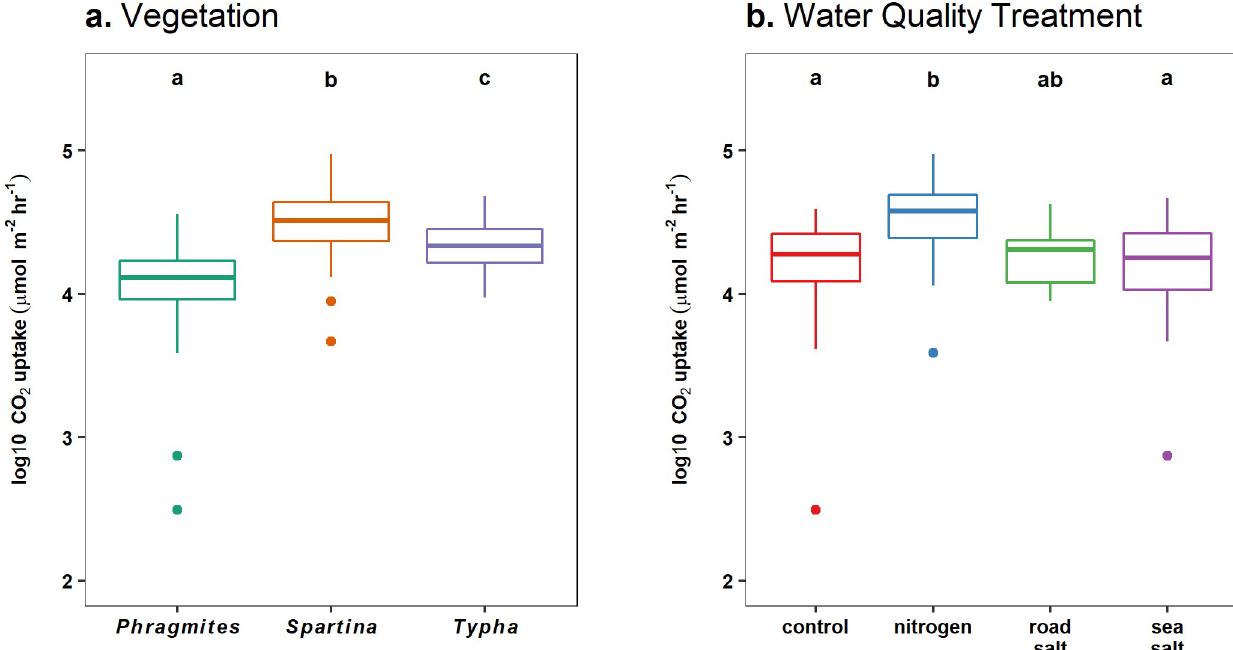
Fig 2. CO 2 uptake differed among vegetation and water quality treatments. Boxplots of 2017 log-transformed CO 2 uptake rates (samples pooled across July, August, September sampling campaigns) by (a) vegetation and (b) water quality treatments. Note that measurements were estimates of net ecosystem exchange, integrating photosynthetic uptake, auto and heterotrophic respiration from transparent chambers. Differences between groups are indicated by non-overlap of letters, based on post-hoc Tukey contrasts.